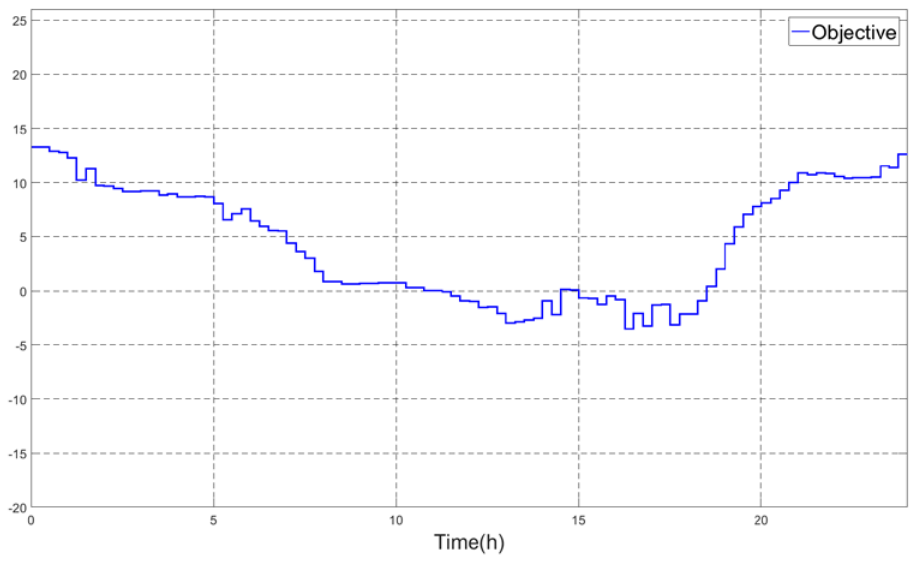
Figure 8. Scenario 1—Value of the objective function. Table 3. Operating data for scenario 1.